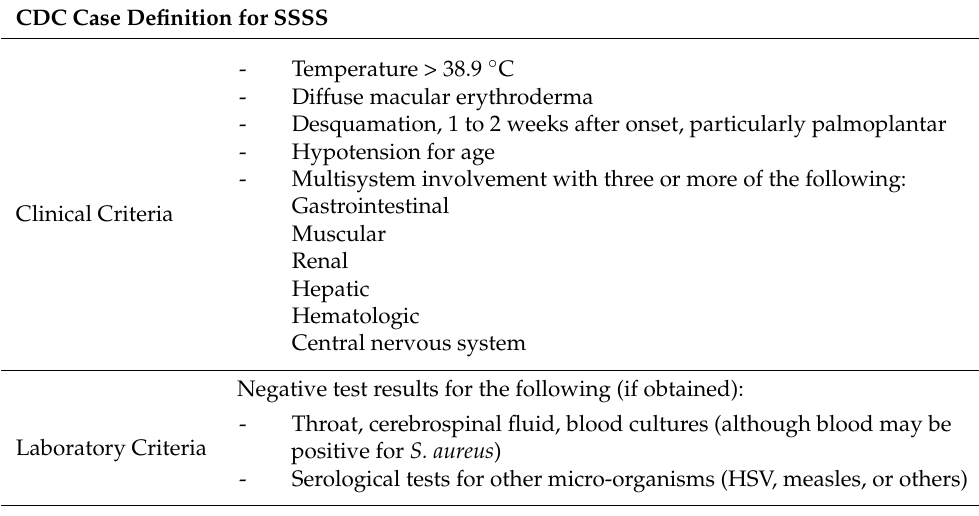
Table 4. CDC Case definition for Staphylococcal Scalded Skin Syndrome